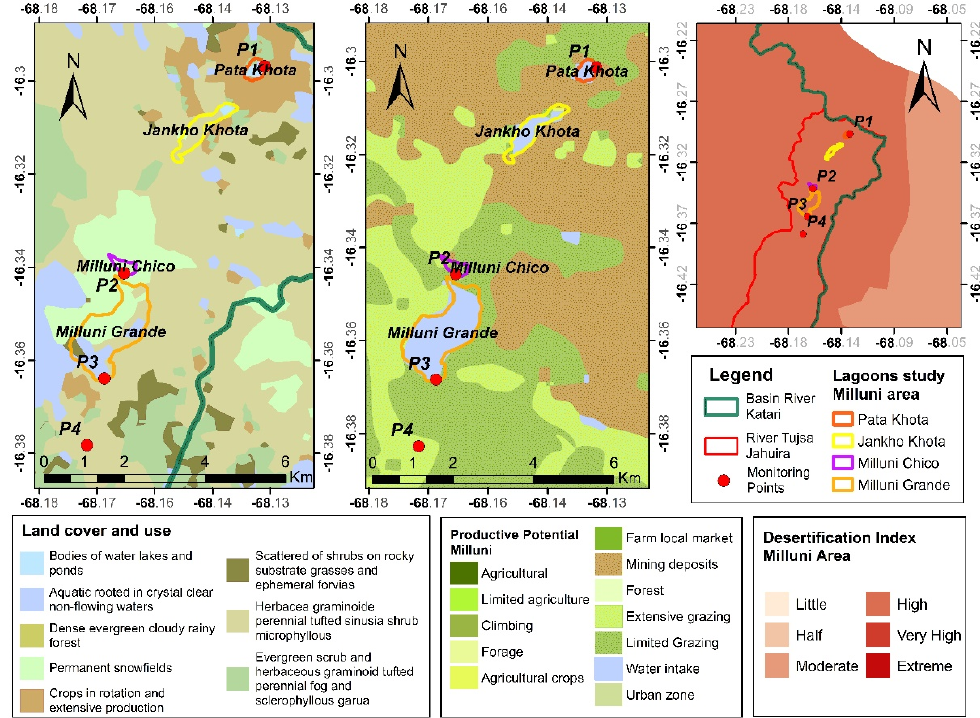
Figure 4. Identify the potential impact on water quality at the points monitored in the Milluni basin .